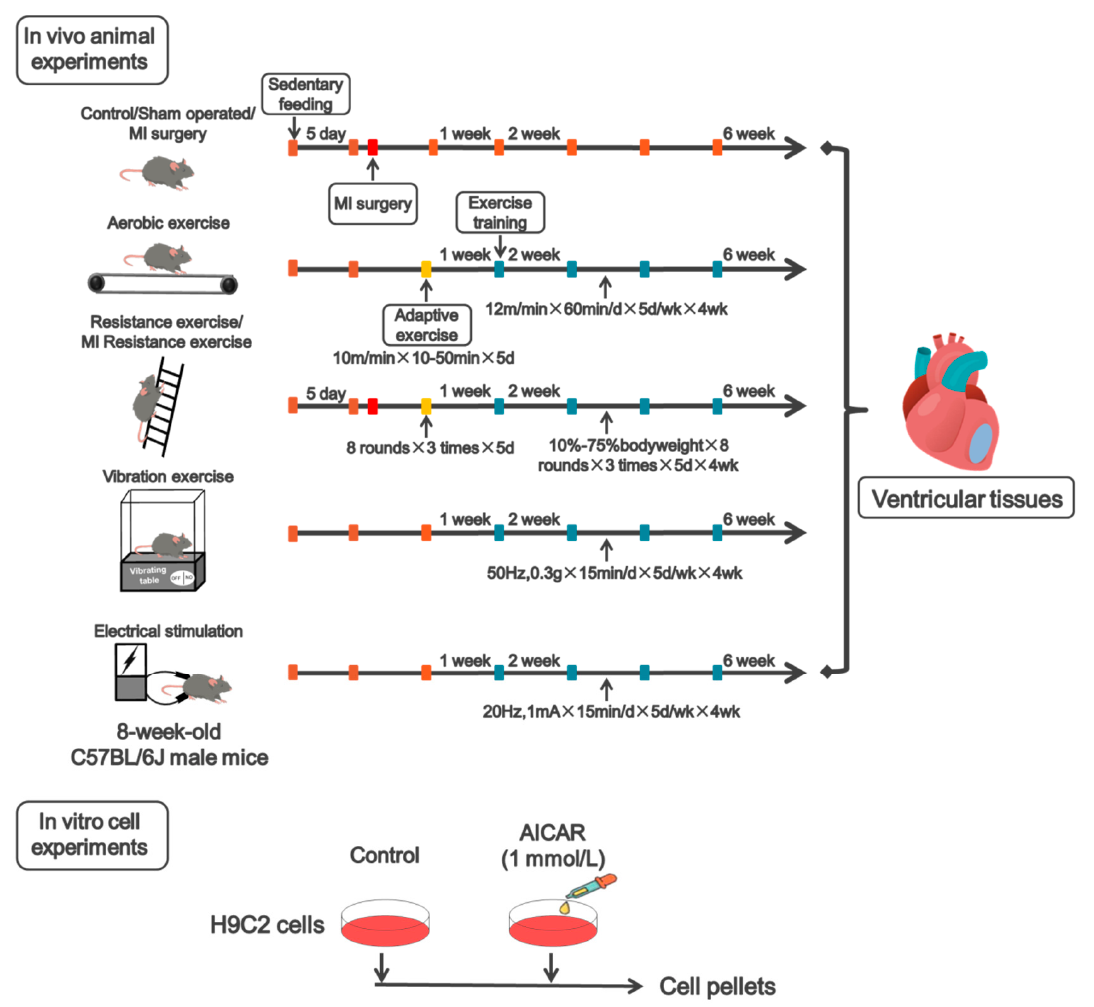
Figure 1. The schematic diagram of animal exercise protocol and cell intervention.